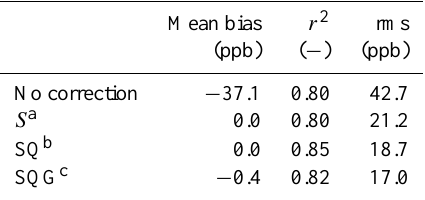
a Uniform bias correction. b Uniform + seasonal bias correction. c Uniform + seasonal + latitudinal bias